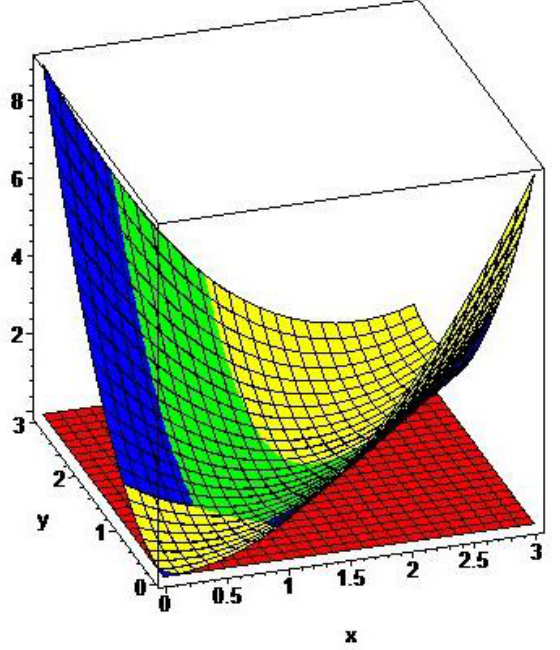
Figure 2. Approximation of B G n , n ( ϕ ) to ϕ (blue) on [ 0,3 ] × [ 0,3 ] for n = 5 (red), n = 25 (yellow), n = 75